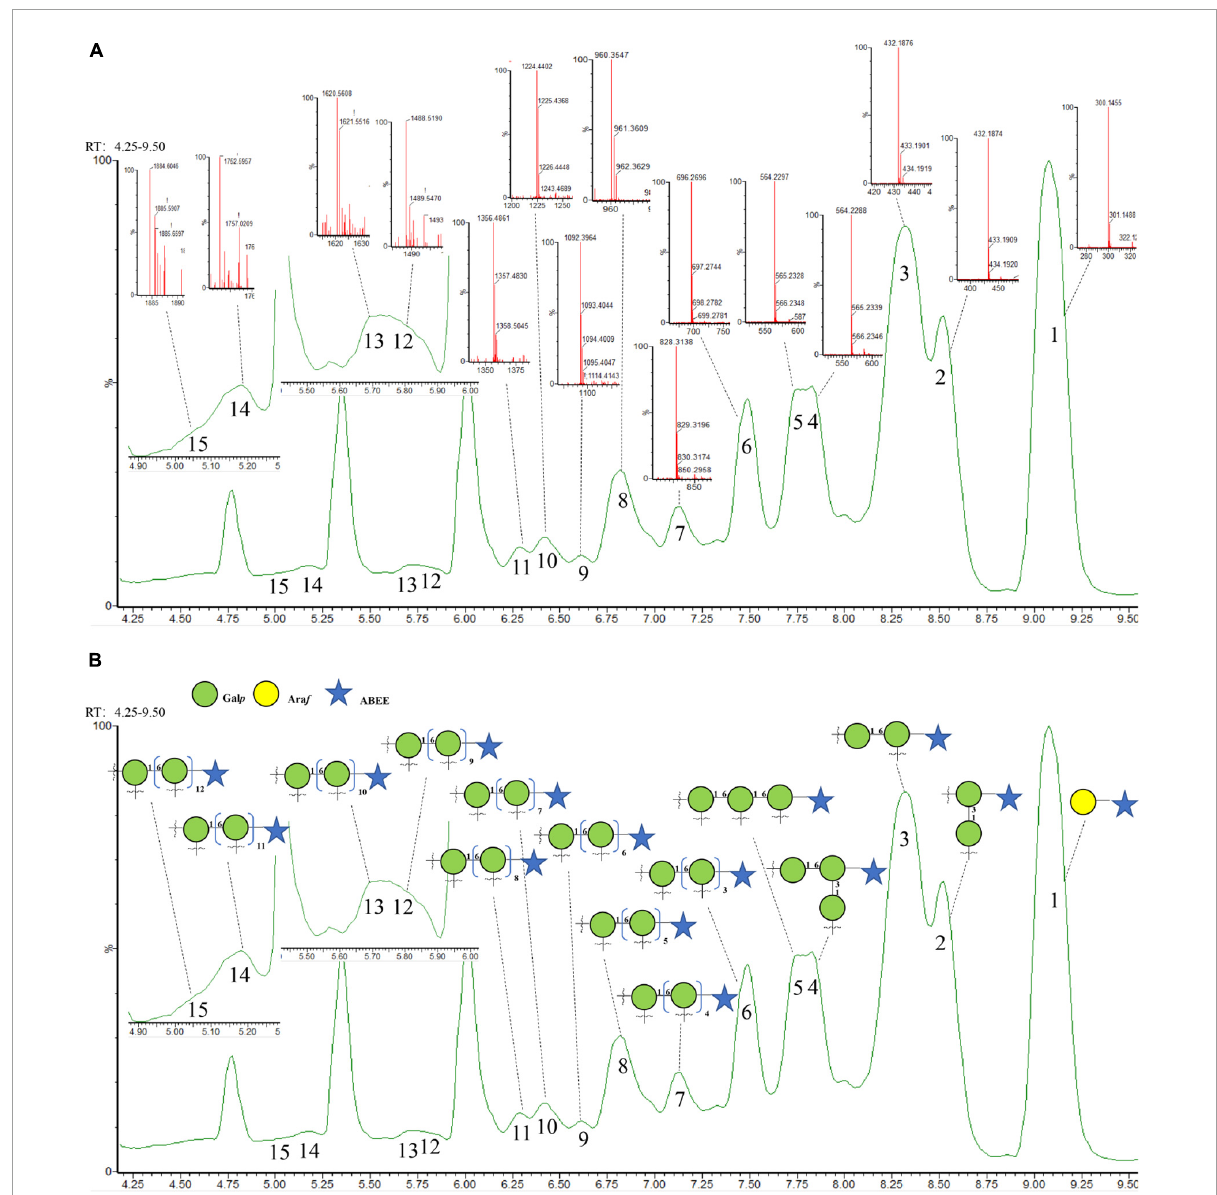
FIGURE4 (A) Annotated base peak and (B) total ion chromatogram of ABEE-labeled oligosaccharides generated from 70 ◦ C of partial acid